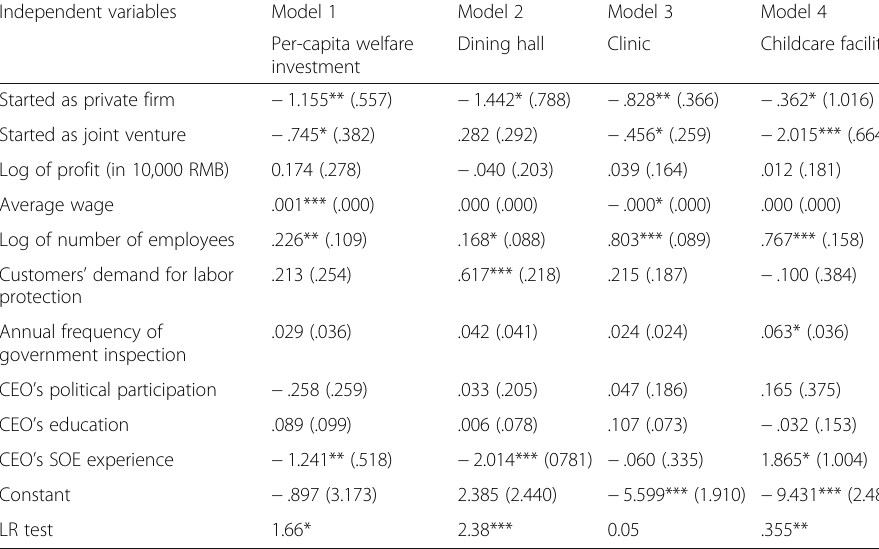
Table 2 Effect of ownership form at founding on organizational welfare